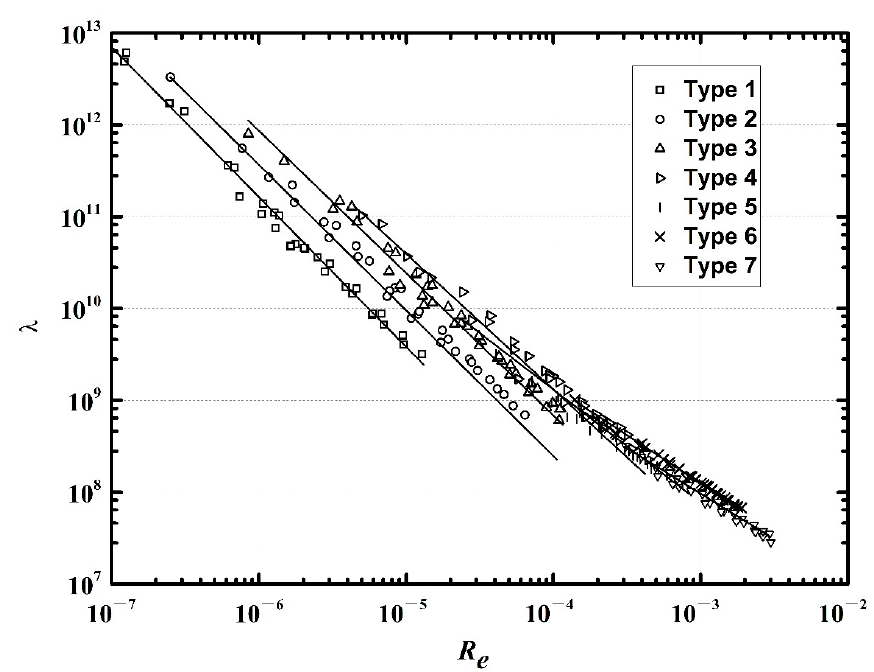
Figure 7. Seepage friction factor, λ as a function of particle Reynolds number, R e . The λ versus R e curve is distinct for a certain sediment type.